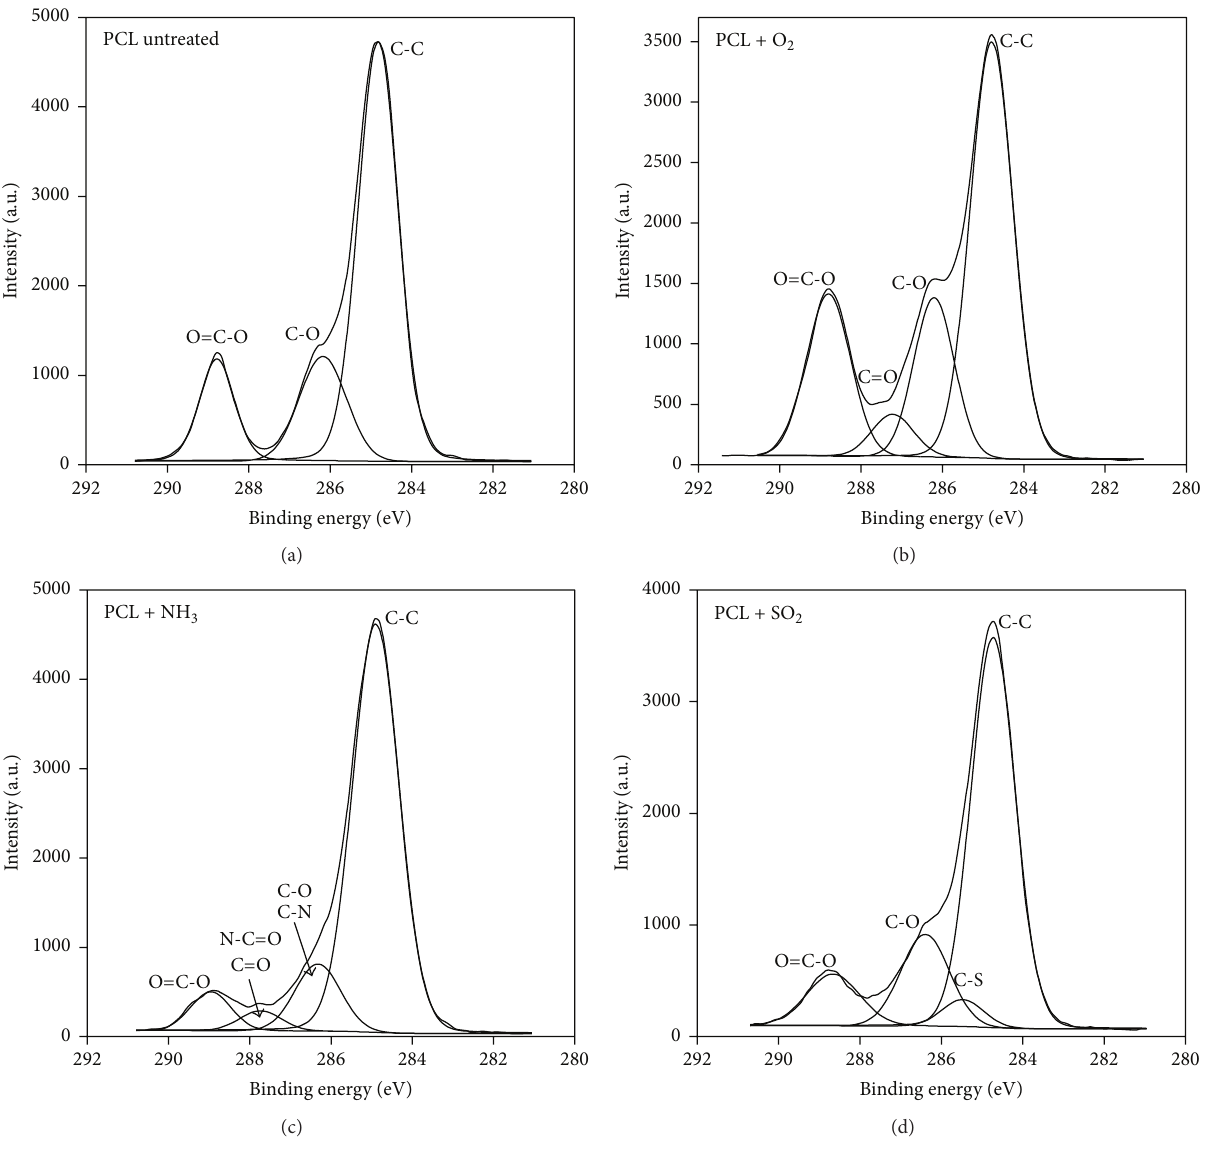
Figure 2: Carbon high-resolution peaks for various plasma-treated PCL